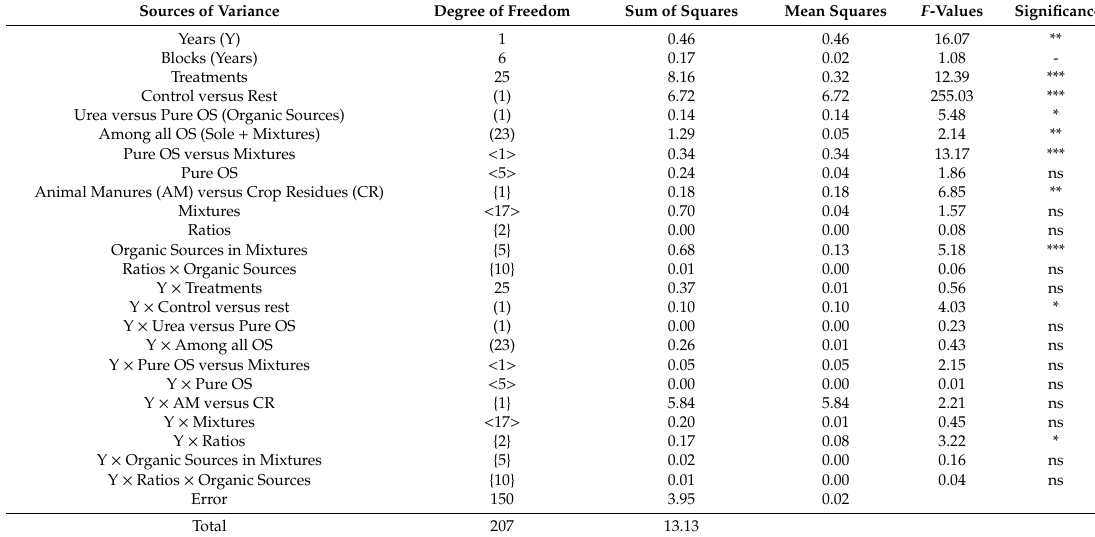
Table 3. Analysis of variance for nitrogen concentration in grains (%) of rice hybrid “Pukhraj” as a ff ected by organic and inorganic